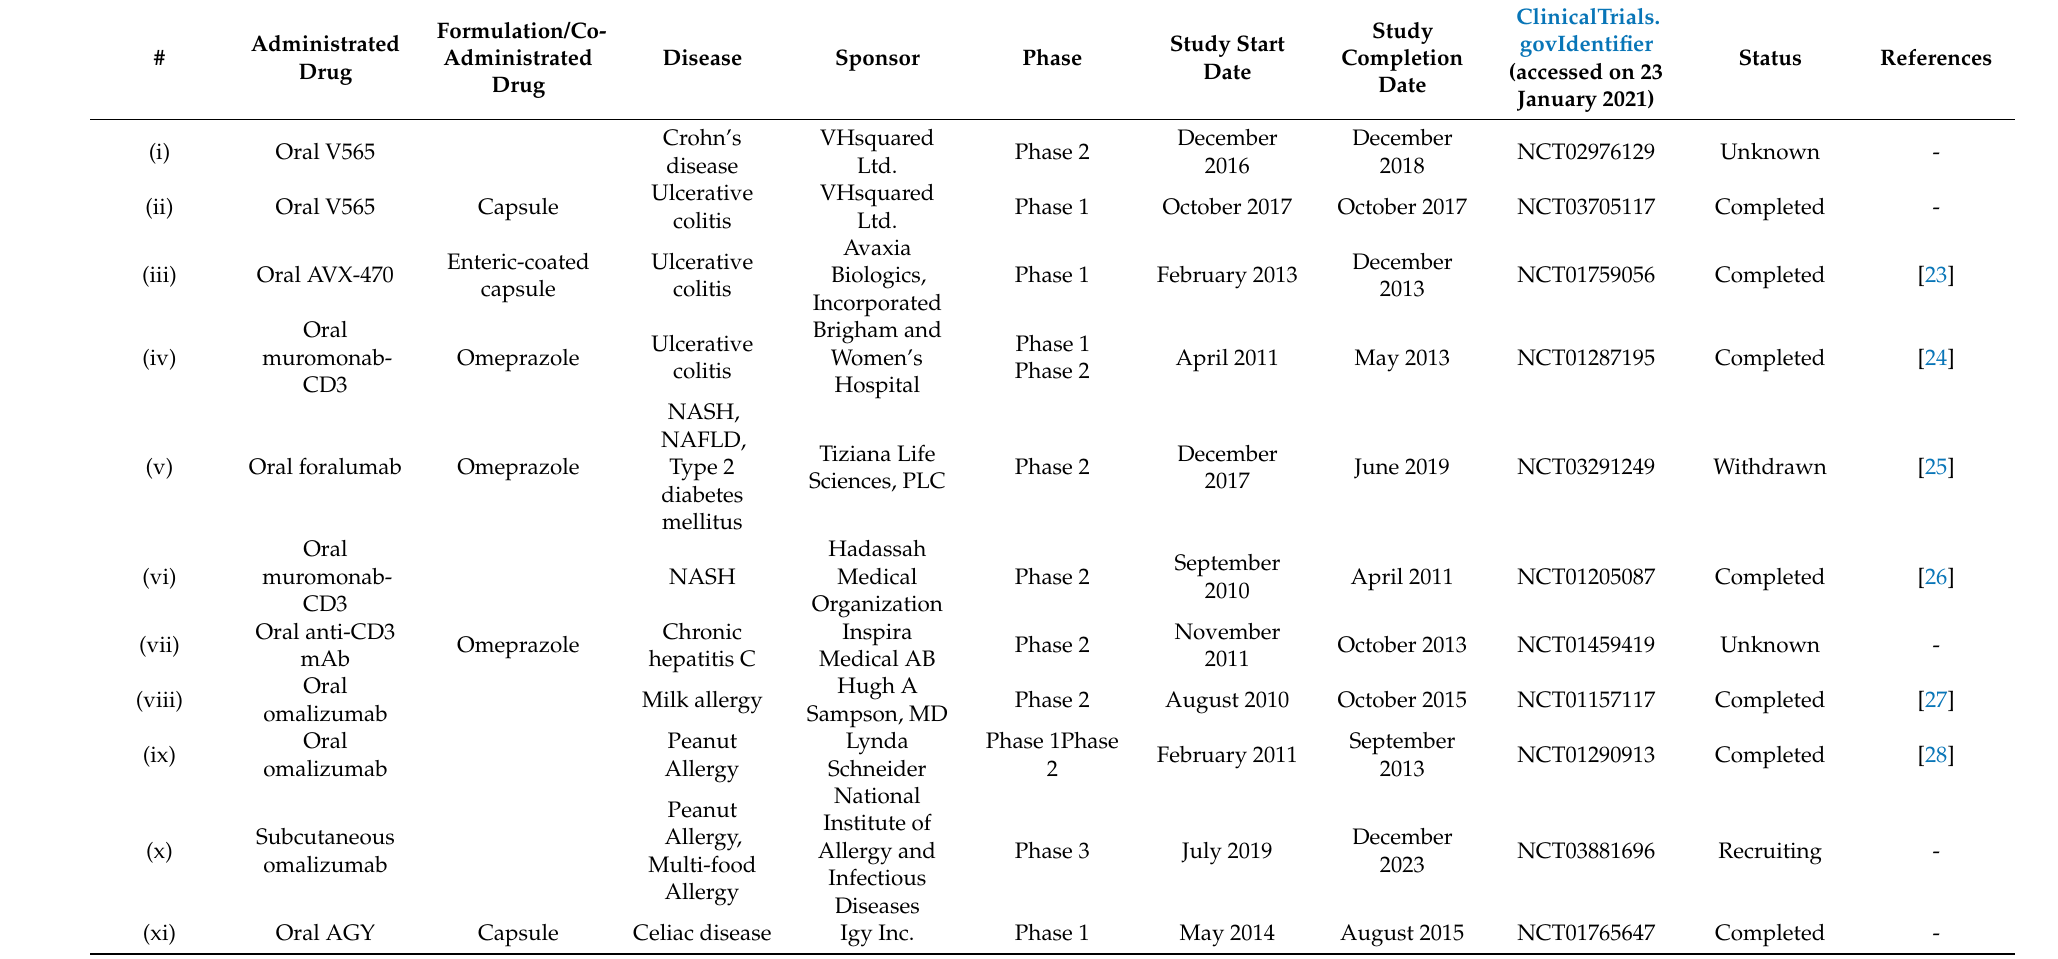
Table 1. Summary of clinical trials focusing on orally administered Ab delivery described in this